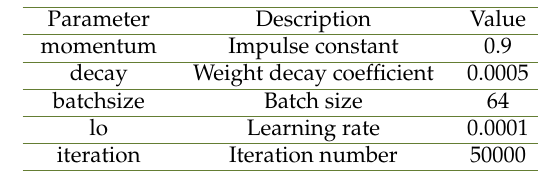
Table 1. Model parameter